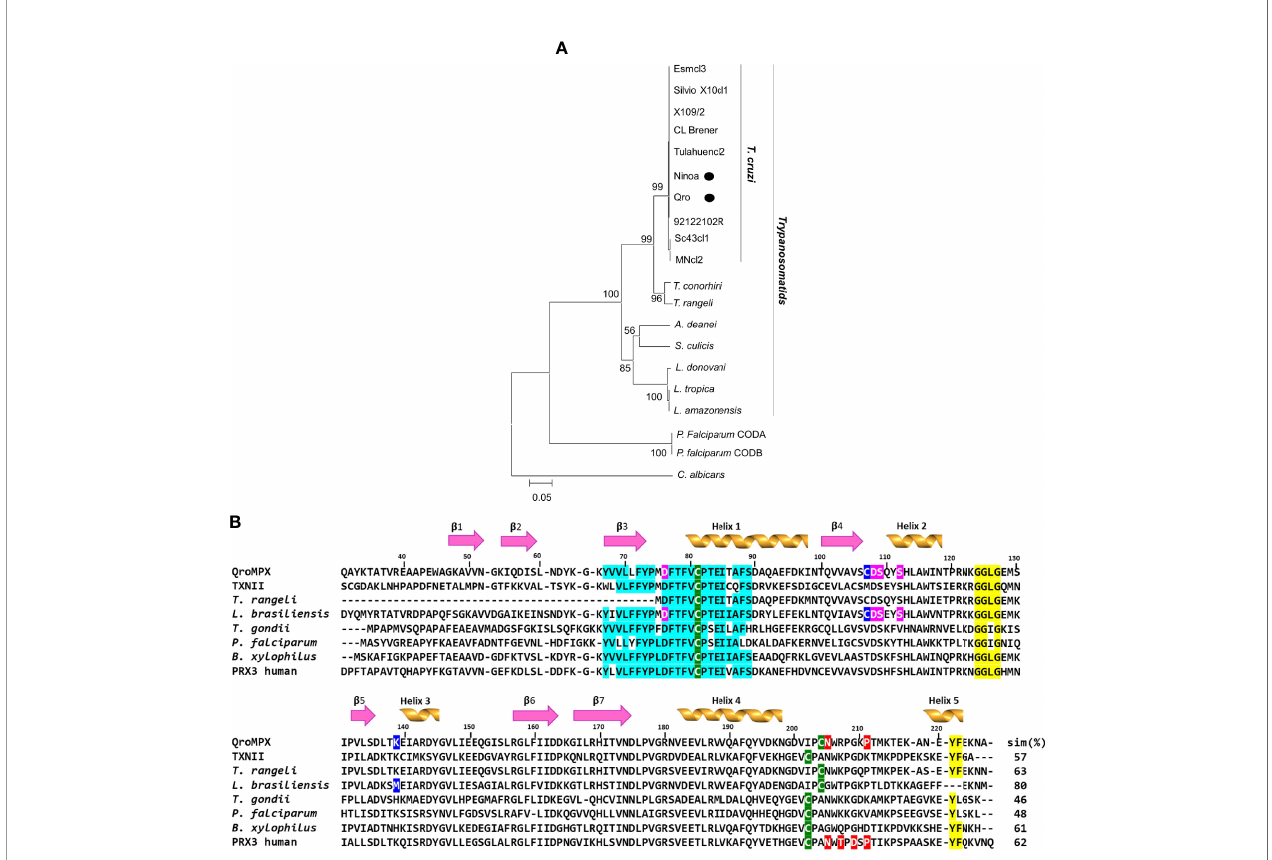
FIGURE 1 | Phylogeny of QroMPX and NinoaMPX and alignment with other mitochondrial PRXs. (A) The phylogeny was inferred using the Neighbor-Joining method. The percentage of replicate trees in which the associated taxa clustered together in the bootstrap test (10,000 replicates) are shown next to the nodes. The evolutionary distances were computed using the p-distance method and are in the units of the number of amino acid differences per site (scale bar). The analysis involved 20 – amino acid sequences. All positions with less than 95% coverage were eliminated. The sequences of TcMPX from Mexican strains Qro and Ninoa ( ● ) were grouped in the clade of trypanosomatids, close to other T. cruzi strains. (B) The sequences were aligned as indicated in materials and methods. Beta sheets (1 – 7) and a-helix are indicated on the corresponding sequence. The numbering corresponds to the position of the amino acids in the sequence of QroMPX. The cysteines of the catalytic site are indicated in green background. The motifs involved in susceptibility (yellow background) and resistance (red background) to hyperoxidation are also indicated. The transmembrane sequence identi fi ed in B. xylophilus (ABW81468.1) and the identical amino acids in the other sequences are indicated in cyan. The amino acids that interact with divalent cations (pink background) and those that stabilize the binding (blue background) identi fi ed in L. brasiliensis (XP_001562236.1) are also indicated in QroMPX. The fi rst 30 amino acids of the QroMPX and L. brasiliensis sequences were cut to facilitate alignment. The other sequences used were from T. cruzi (TXNII, PDB 4LLR), T. rangeli (ESL05855.1), T. gondii (AAG25678.2), P. falciparum (BAA97121.1), and human PRX3 (PDB 5JCG). At the end of each sequence, the percentage of similarity (sim%) with QroMPX is